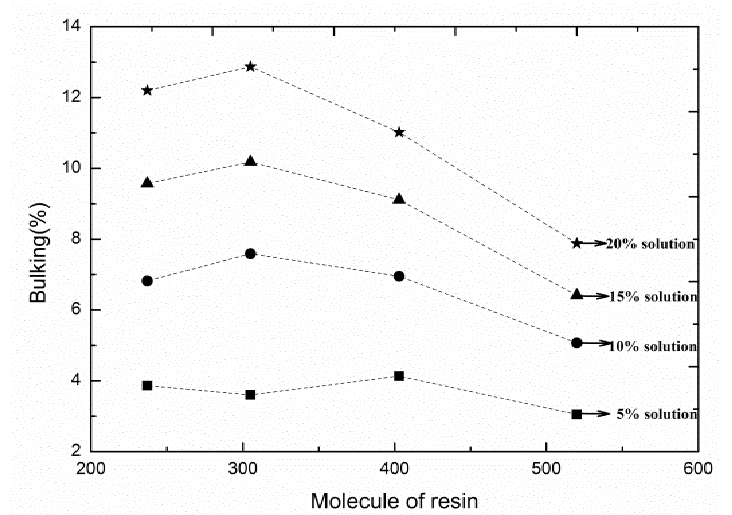
Figure 3. Bulking effect in wood samples treated with PF resins.